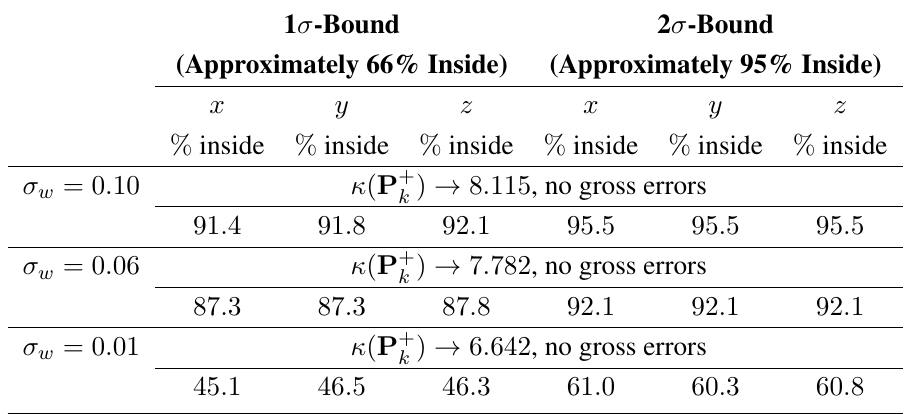
Table 2. Percentage of filtered positions inside the 1 σ - and 2 σ -bound and the condition number of matrix P + k